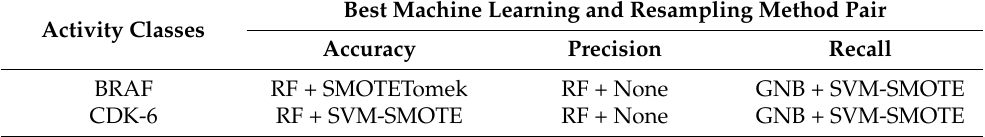
Table 3. Best machine learning and resampling method pair for all cancer-related activity classes in terms of accuracy, precision and